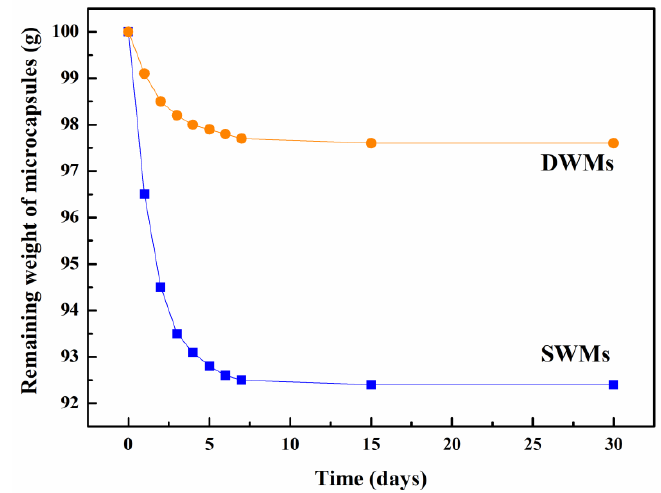
Figure 4. Remaining weight of SWMs and